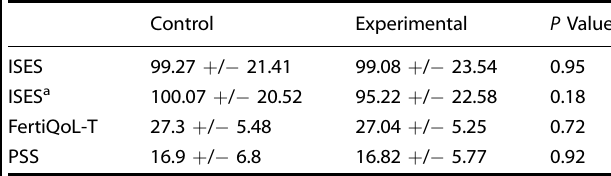
Table 1. Participant characteristics. Table 2. Outcomes from intention to treat